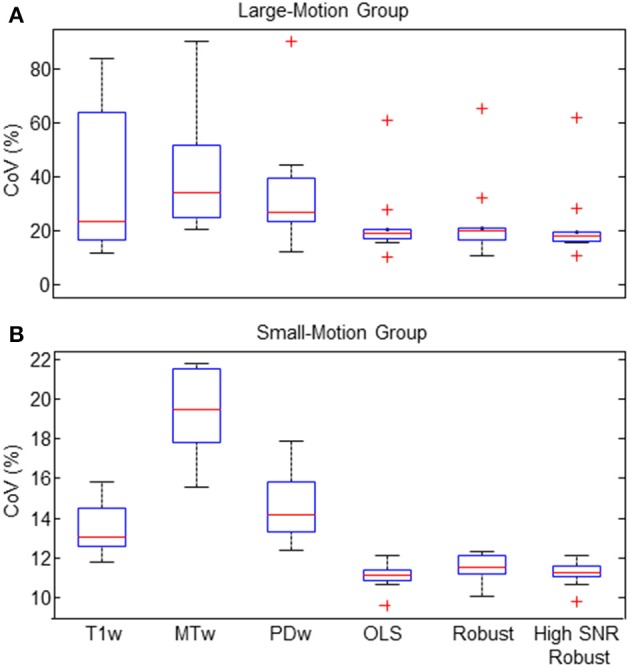
Coefficient of varation (CoV) of R2* was reduced by ESTATICS (as measured in the frontal white matter ROI). (A) In the large-motion group the CoV was considerably reduced using ESTATICS. Also the consistency between volunteers was increased as can be seen by reduced inter-subject variation. (B) In the small-motion group the CoV was also reduced using ESTATICS but the absolute effect was smaller. Box plots provide descriptive statistics for CoV across the group with blue box = 25/75% percentile, red line = median, black whisker = most extreme data value excluding outliers, red cross = outlier (probability < 0.01 under assumption of normally distributed data). Note the different scale of the y-axis for the data of small-motion and large-motion groups. See Figure 1 for explanation of abbreviations.